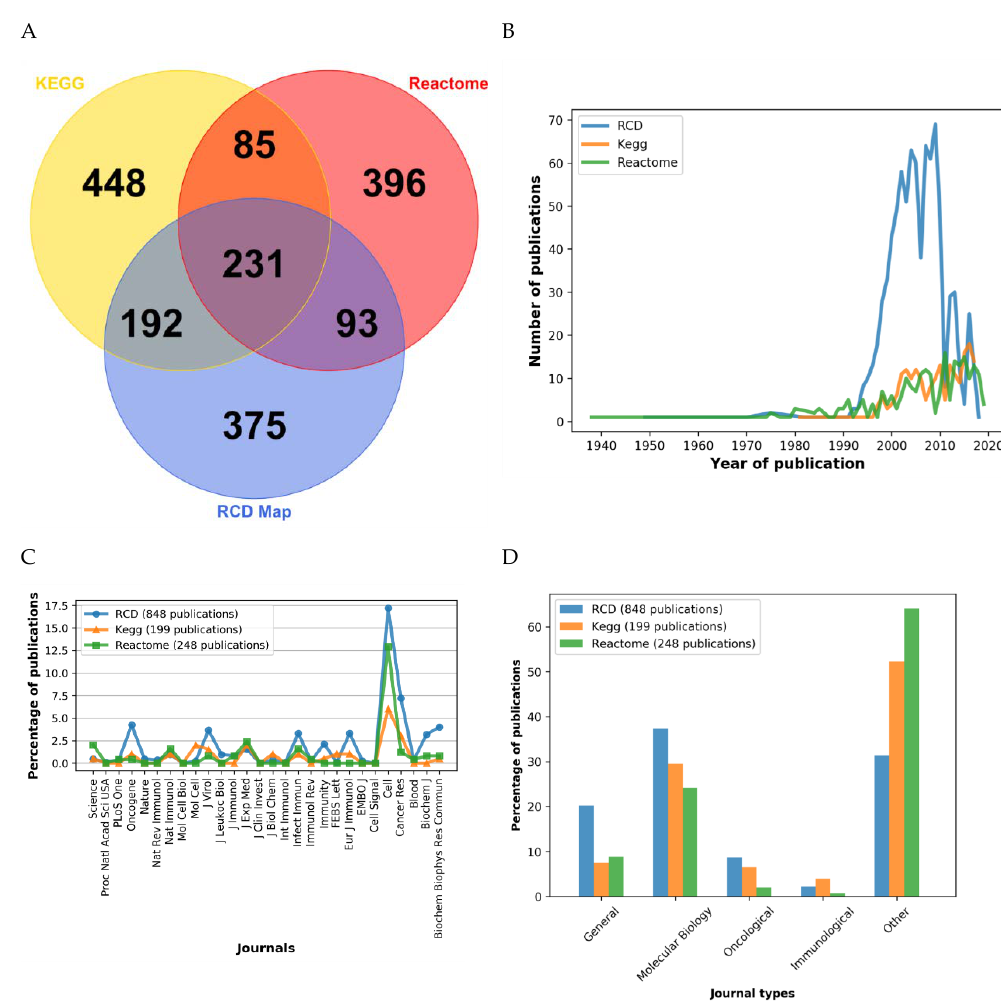
Figure 4. Comparison of RCD Map with other pathway resources. ( A ) Comparison of HUGO names content in selected pathways from REACTOME and KEGG databases with the RCD map. The Venn diagram shows the overlap of HUGO names between different databases. Distribution of ( B ) publication years and ( C ) journals annotating the selected pathways from the REACTOME, KEGG, and RCD map. ( D ) Relative distribution of journals types used for annotation of the selected pathways from REACTOME, KEGG, and RCD map.